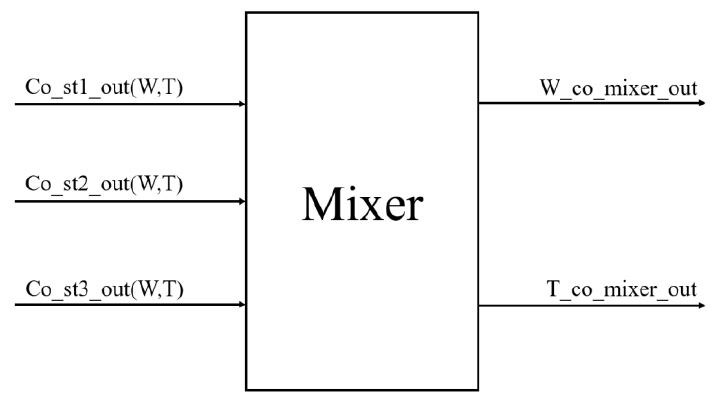
Figure 2. The input and output of the mixer model.